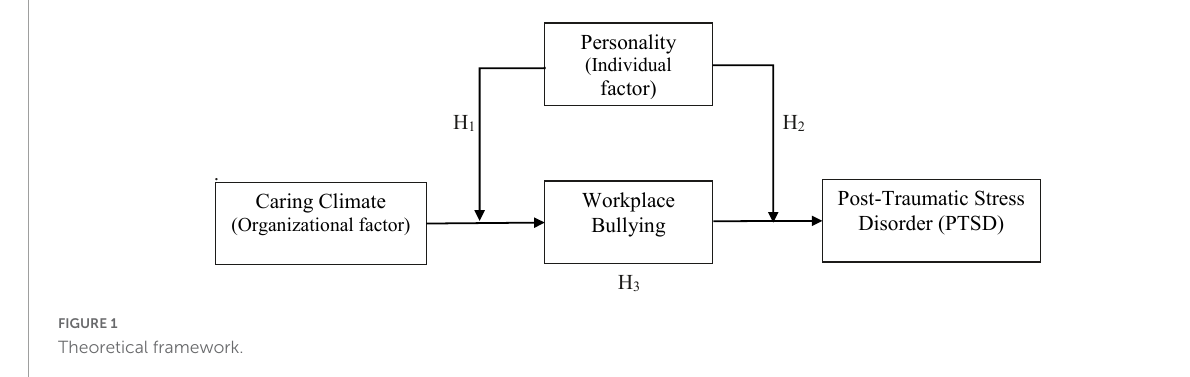
FIGURE1 Theoretical framework.